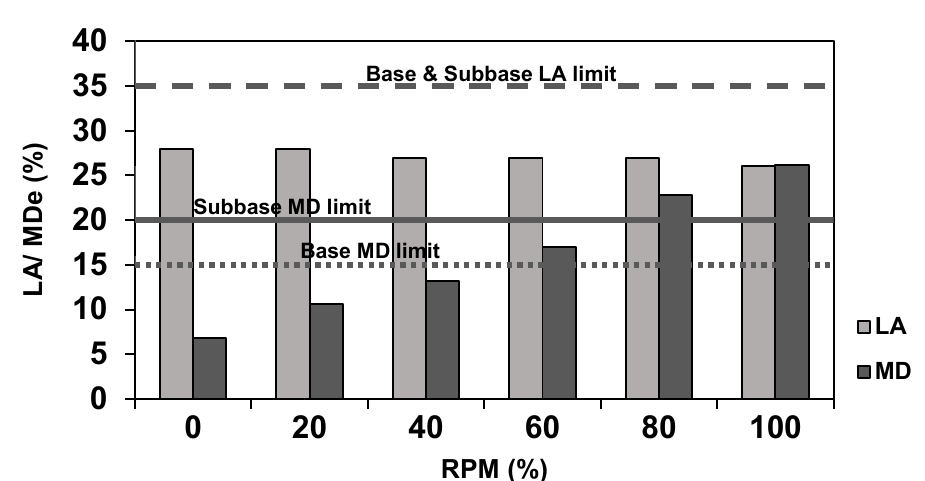
Figure 2. LA and MD performance of REM and mixed with RPM, adapted from [14].